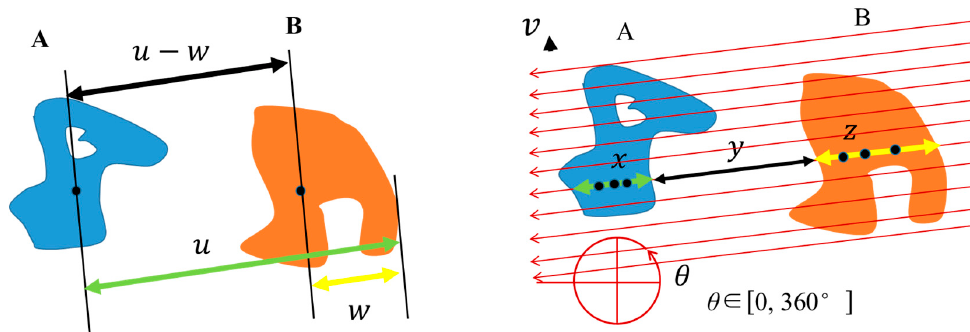
Figure 2. Calculation of the histogram of force. The histogram in one direction is calculated by Equation (1). We then sum the force in all the scan lines with the same direction, and traverse to acquire all the directions.